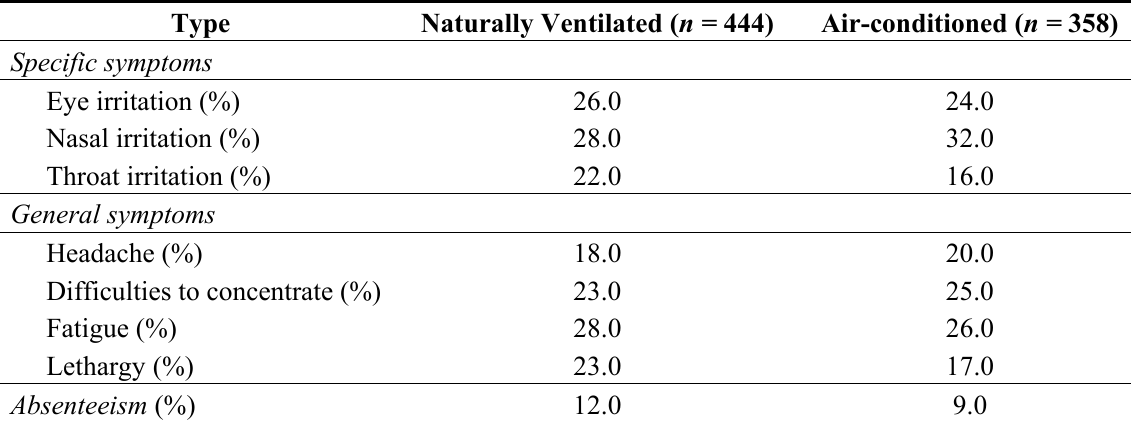
Table 3. Symptoms and absenteeism in students from NV and AC